Question: What type of chart is this?
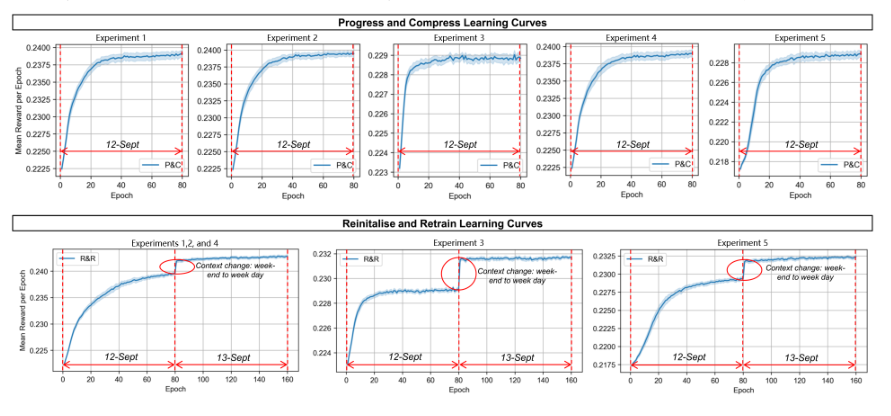
Answer: line